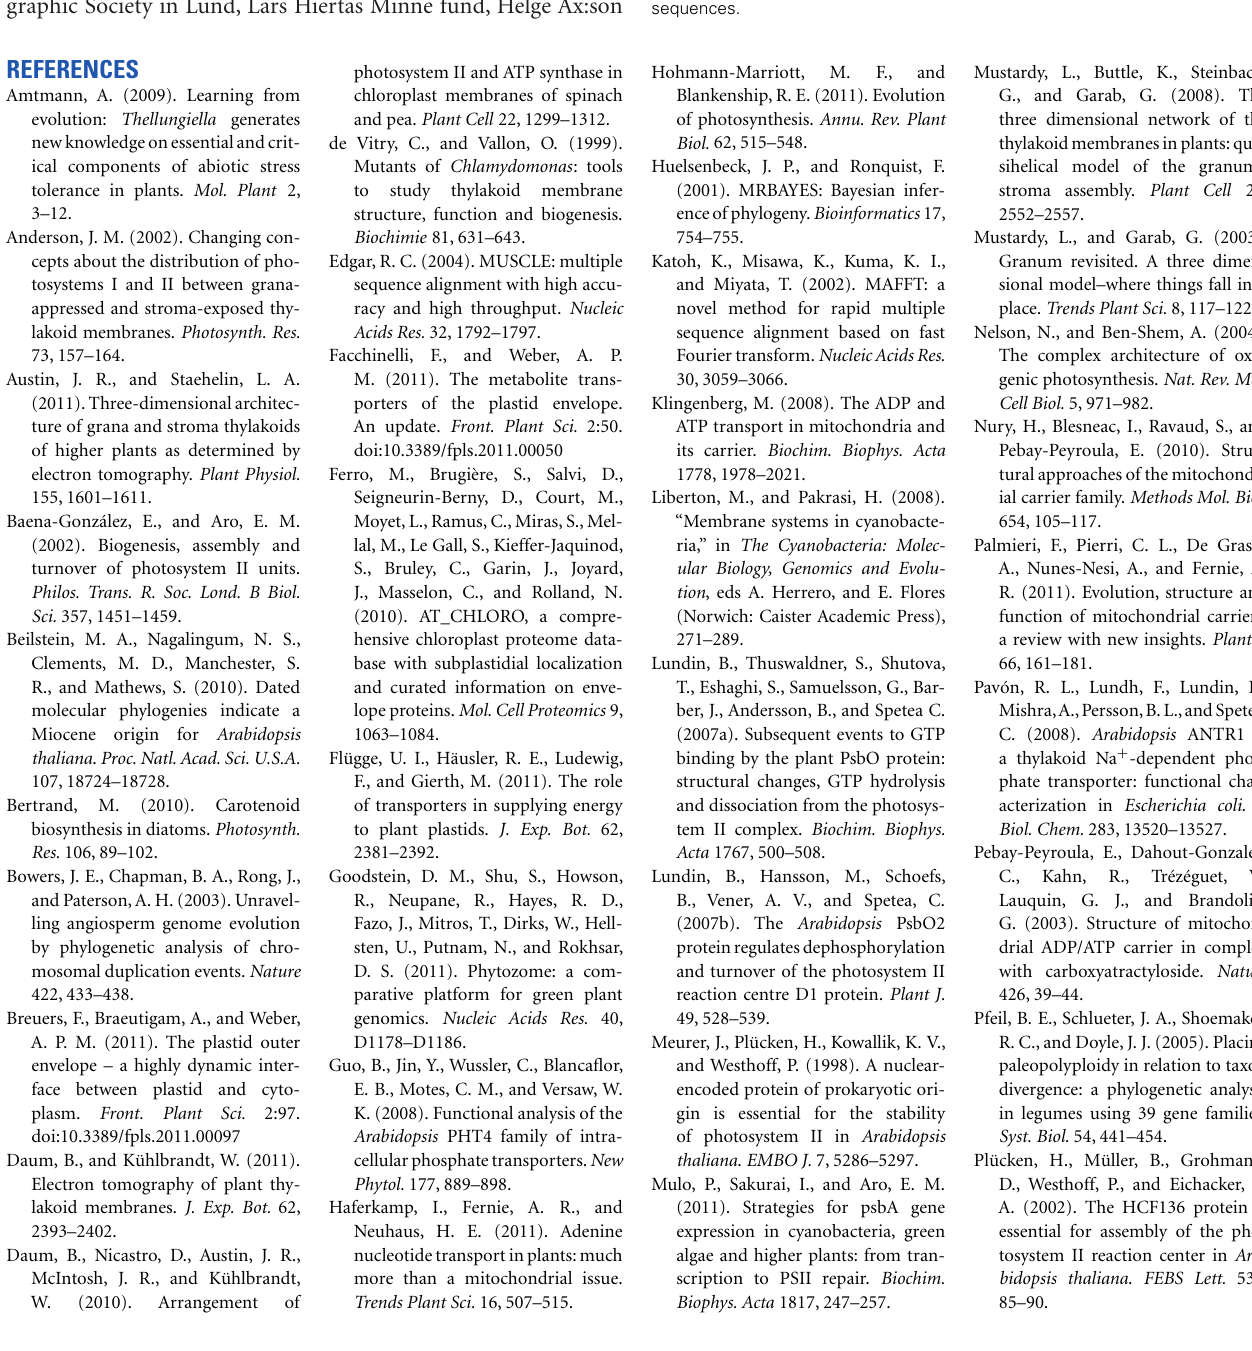
Figure S1 | MUSCLE alignment ofTAAC subfamily of full-length amino acid